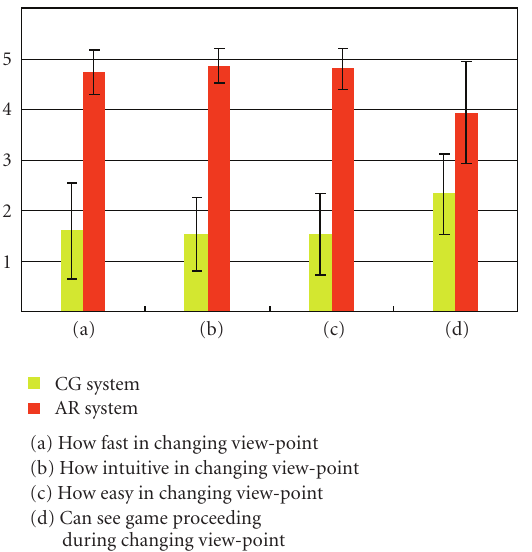
Figure 22: Answer of questionnaire about changing view points.